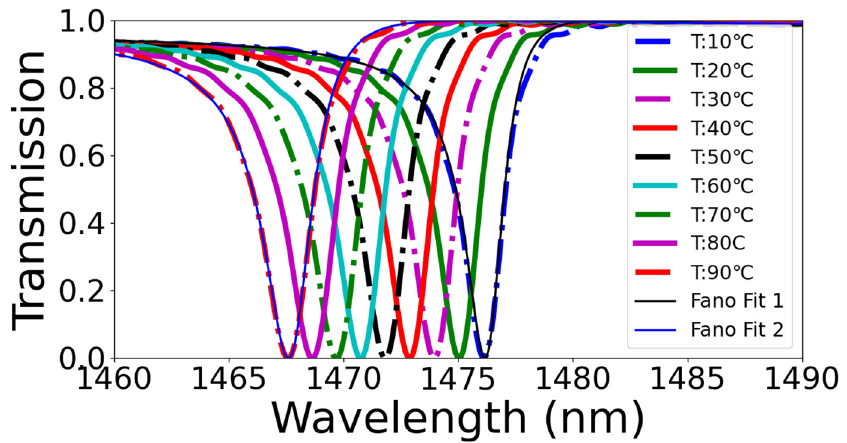
Figure 5. Shift in the resonant modes as the ambient temperature varies from 10 to 90 °C. The first and last resonant mode is curve-fitted using the Fano-resonance lineshape function.